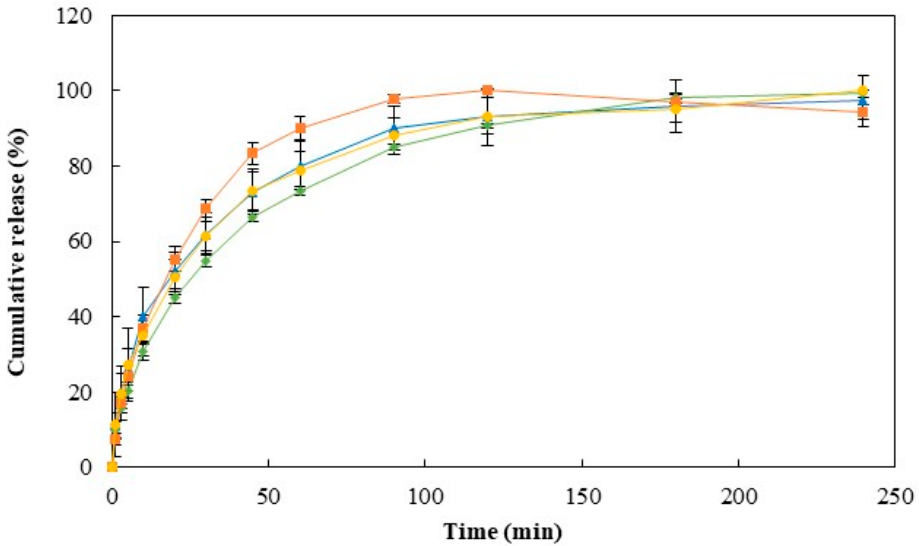
Figure 7. Cumulative release profile of caffeine ( , blue line), diclofenac sodium ( , green line), salicylic acid ( , orange line), and ibuprofen sodium ( , yellow line) of Na5 1 * 4 hydrogels in PBS, at 37 °C.